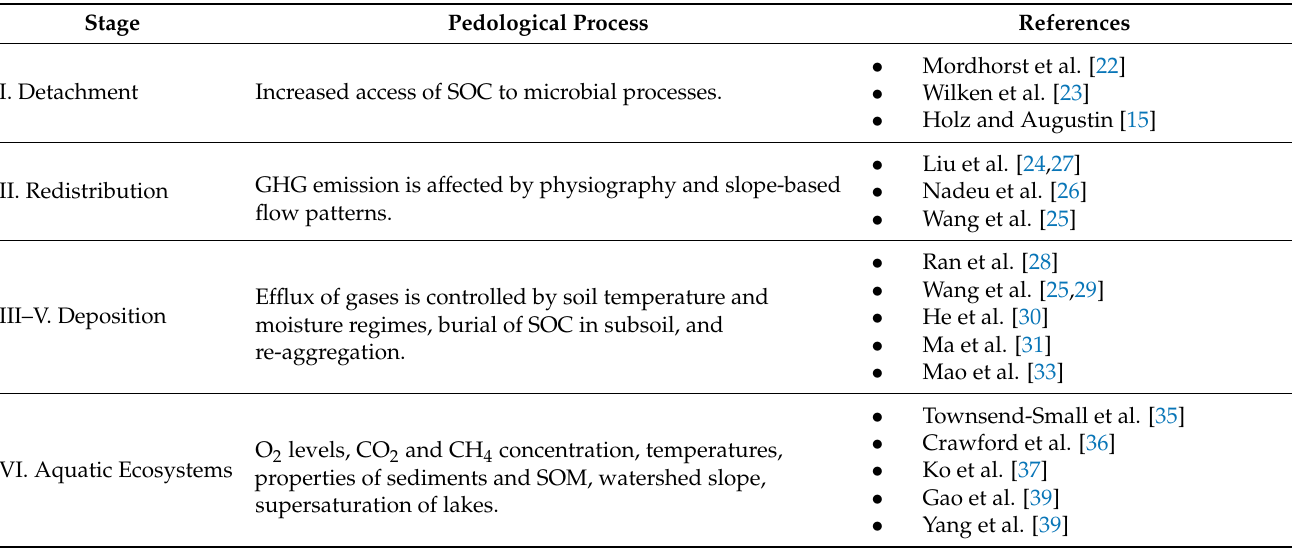
Table 1. Research studies which indicate the efflux of CO 2 and other greenhouse gases at different stages of hydric